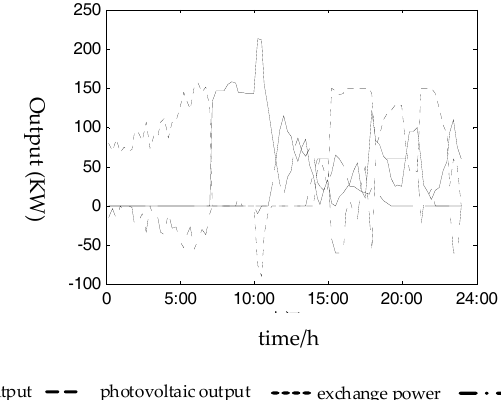
Figure 4. The power supply structure of the load.